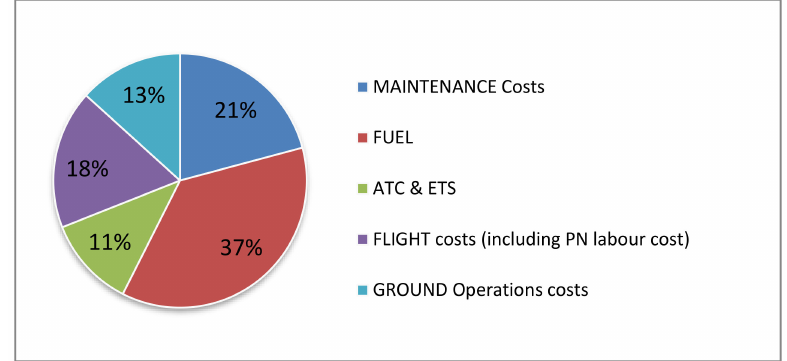
Figure 1. Airline’s operating expenses.